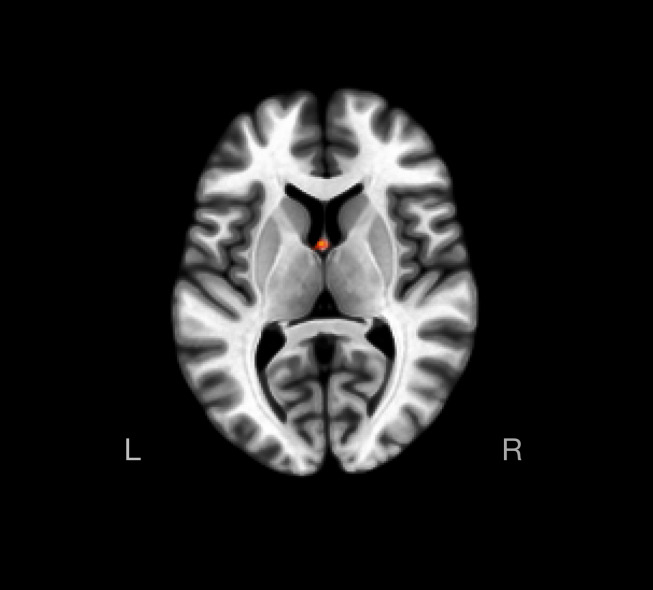
Between-group hippocampal seed-to-voxel functional connectivity, at a lenient, p-uncorrected <0.05 cluster-size threshold.Left and right hippocampal seed regions were not associated with significant between-group differences in functional connectivity, when assessed at a cluster-size p-FDR set at <0.05 and height threshold set at p-uncorrected <0.001 (two-sided). Axial image depicts activity in a cluster that exhibited functional connectivity with the left hippocampal seed region at a lenient, p-uncorrected <0.05 cluster-size threshold. There were no significant clusters for the right hippocampal seed region even when between-group differences were assessed at a cluster-size threshold set at p-uncorrected <0.05 (see Supplementary file 1o).